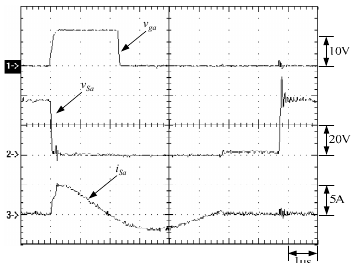
Figure 31. Waveforms pertaining to S 2 at the rated load: (1) v g 2 ; (2) v S 2 ; the (3) i S 2 .